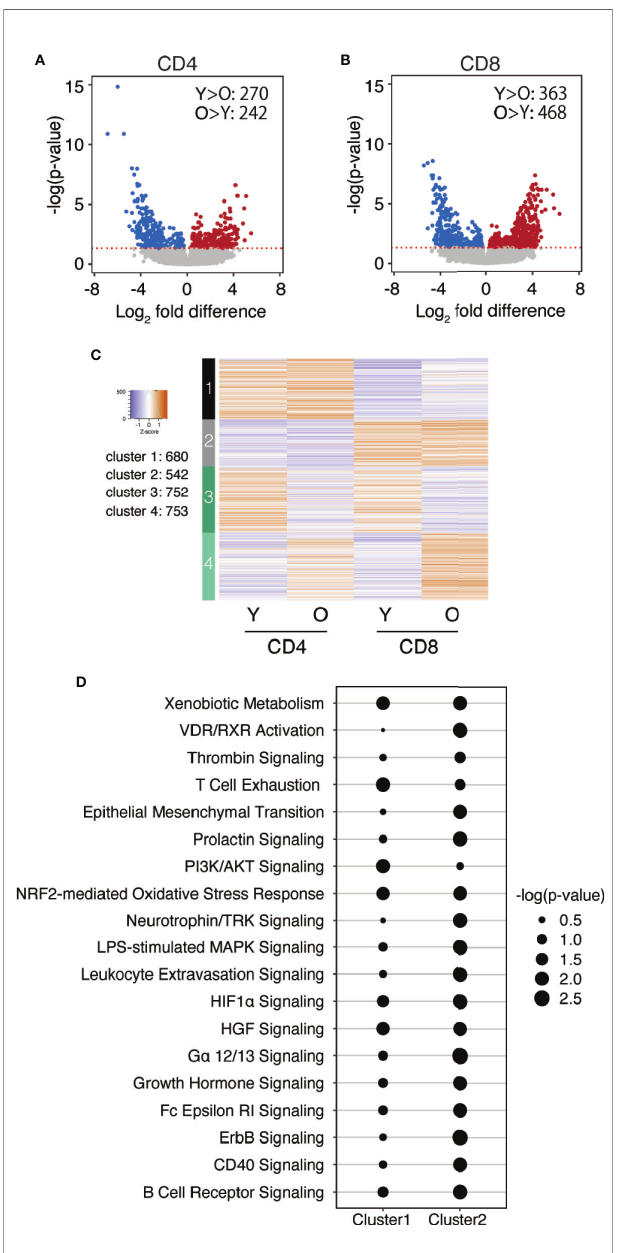
FIGURE 4 | Age-associated transcriptional differences in naïve CD4 and CD8 T cells. (A , B) Volcano plots show the log2 fold differences between young and old individuals at transcript level comparing naïve (A) CD4 and (B) CD8 T cells. Colored dots [more expressed in old (red) or young (blue)] indicate differentially accessible sites with Benjamini-Hochberg adjusted p-values of <0.05, red dash line indicates adjusted p value of 0.05. (C) Heat plot shows transcript levels as derived from RNA-seq data for all genes that had been linked to differentially accessible sites by GREAT as described in Figure 2 . Results of k -means analysis are shown as heat plots with four clusters, with columns representing CD4 and CD8 naïve T cells from young and old adults and colors z -scores of transcripts level. (D) Gene sets within each cluster were examined for pathway enrichment using the Ingenuity Pathway Analysis software. Pathways are given for Clusters 1 and 2, with dot sizes indicating the level of signi fi cance. Signi fi cantly enriched pathways were not identi fi ed for Clusters 3 and